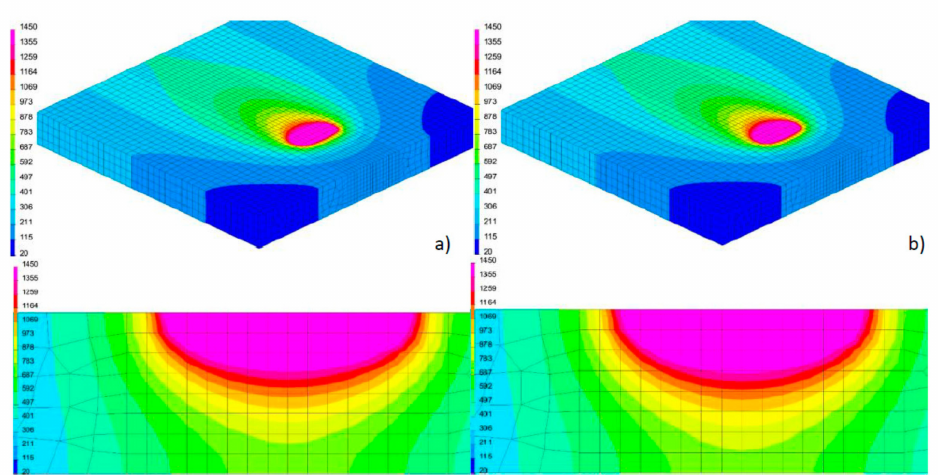
Figure 22. Comparison of the view of the molten pool surface and cross-sections ( a ) when using a model consisting of normal distributions and ( b ) a double-ellipsoid heat source